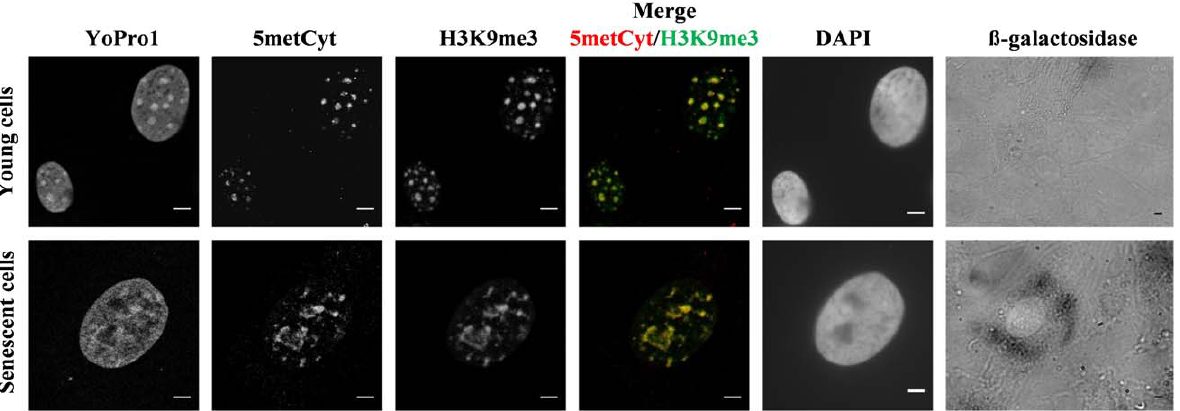
Figure 1. Distribution of heterochromatin domains in young and senescent bovine cells. Young cells from confluent culture of bovine fibroblasts (upper panel; n=150) and senescent cells at late passages of the same culture (lower panel; n=95) were immunostained to detect 5- methylcytosine (red) and H3K9me3 (green). Simultaneously, the nuclei were counterstained with YoProI and DAPI, and the cells were tested for b - galactosidase activity. Note the colocalization of H3K9me3 and DNA methylation in senescent and young cells. Images were obtained from confocal Z-stack projections. Scale bars: 5 m m.